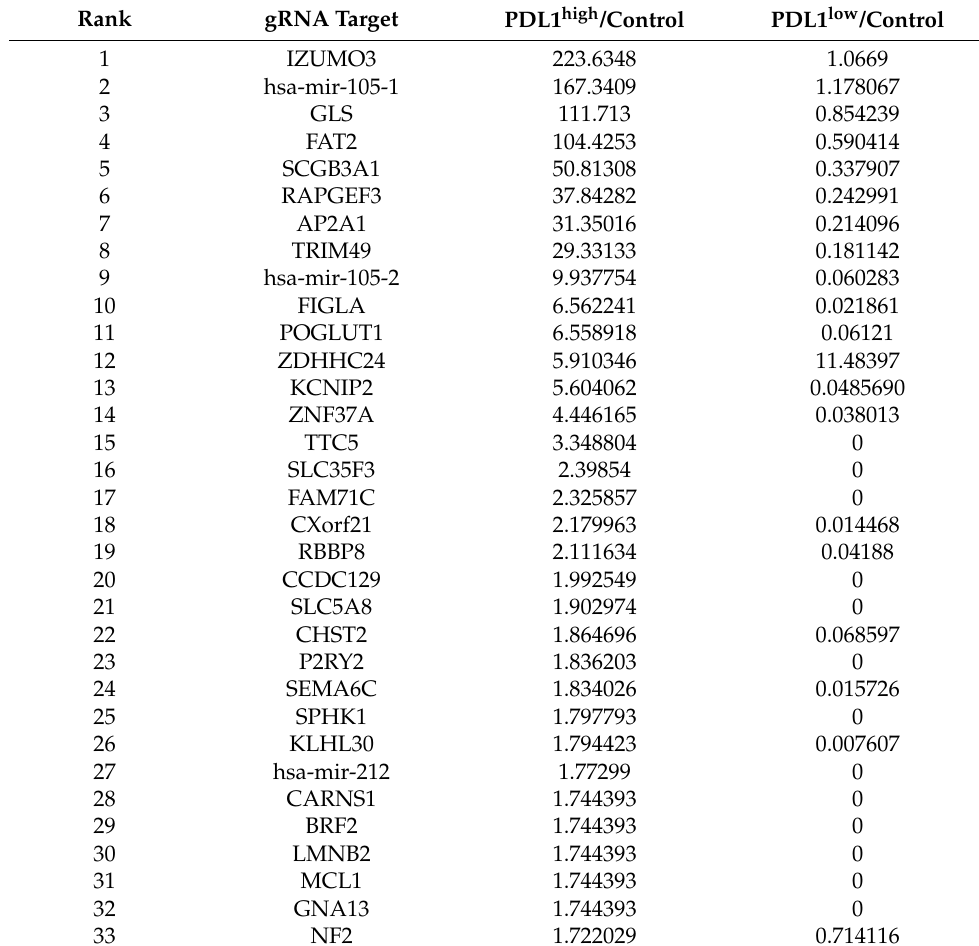
Table 2. gRNAs ranked by enrichment in PDL1 low over control.